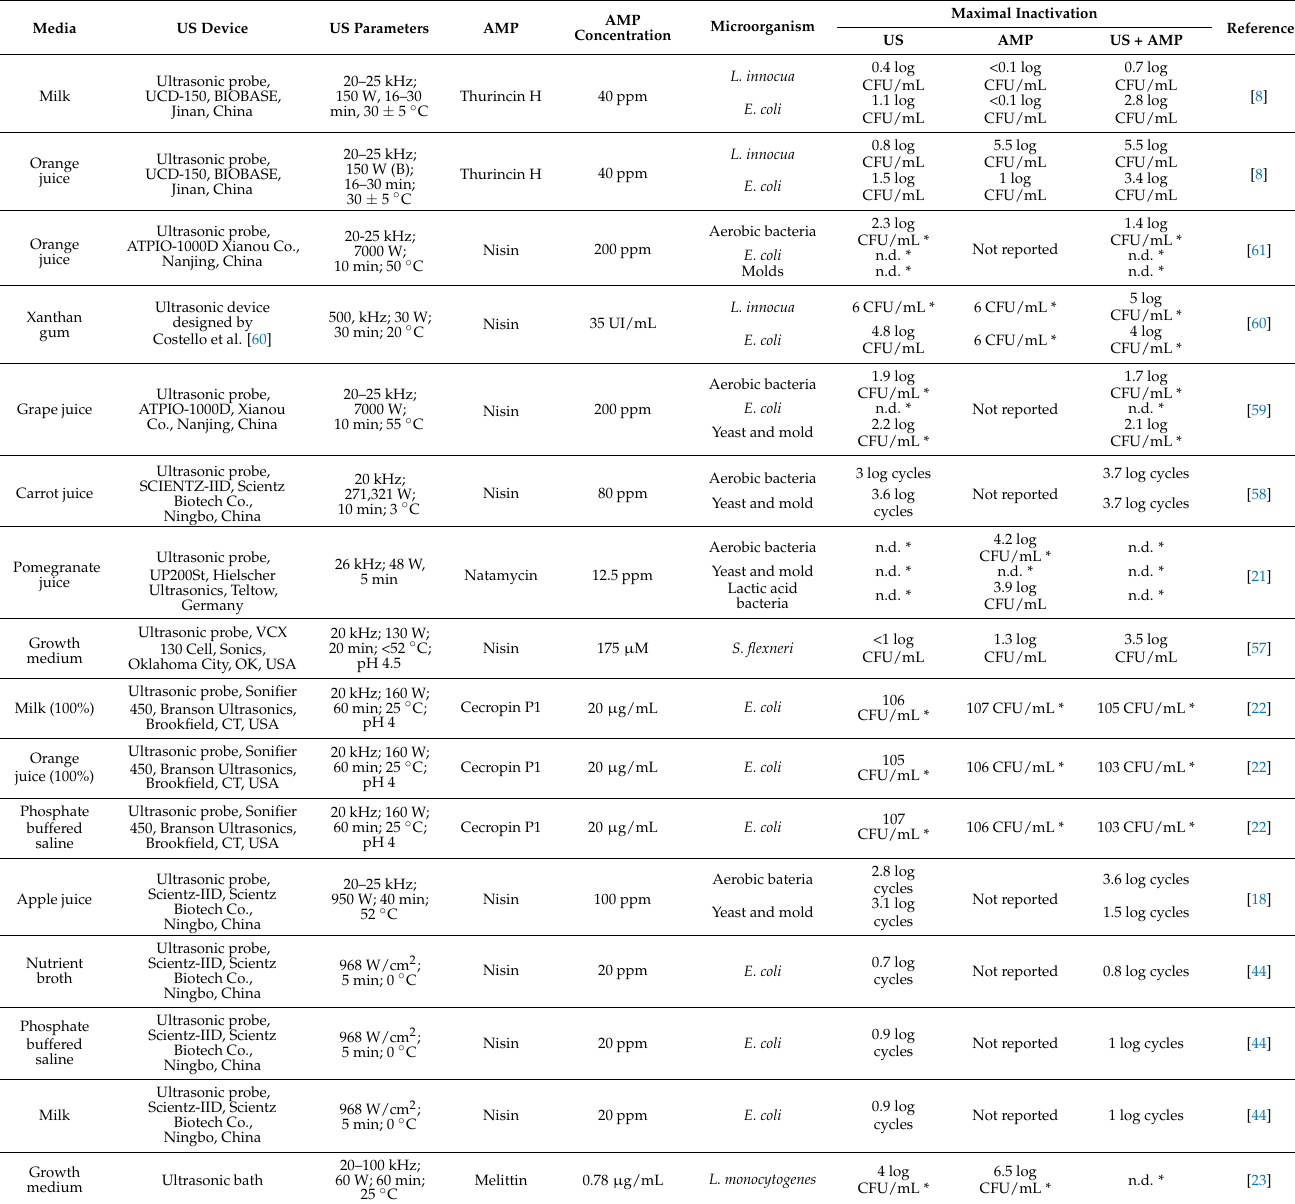
Table 4. Effect of ultrasound (US) and antimicrobial peptides (AMPs) on microbial inactivation in food